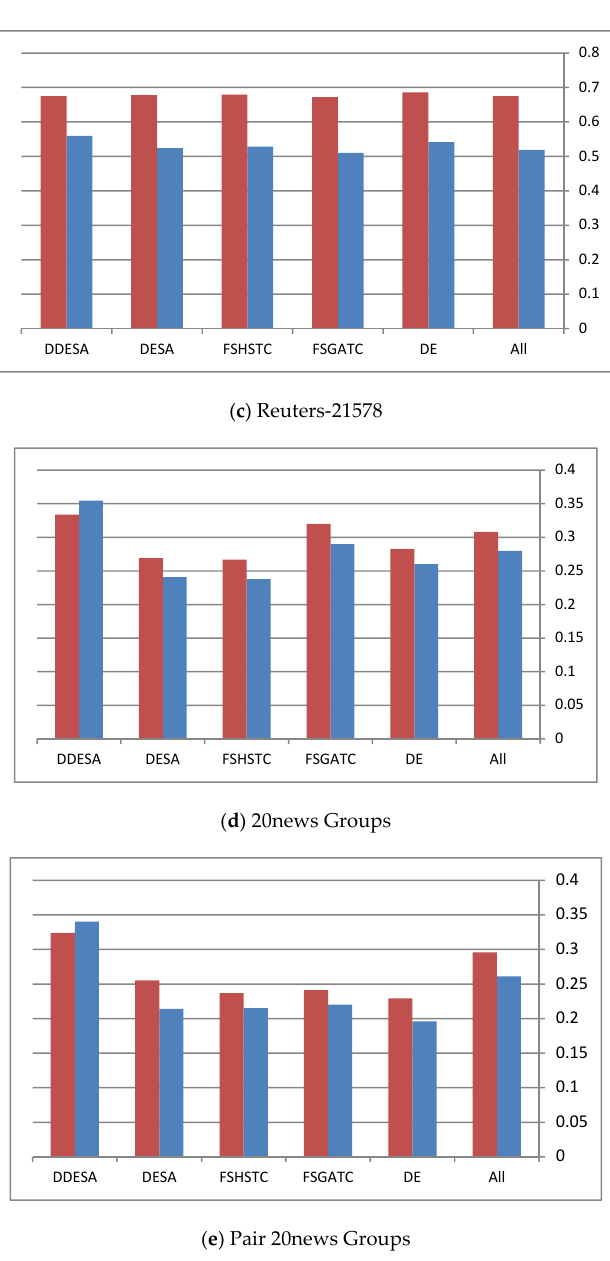
Figure 4. (a – e) The performance of different algorithms on the different datasets. Figure 4. ( a – e ) The performance of di ff erent algorithms on the di ff erent